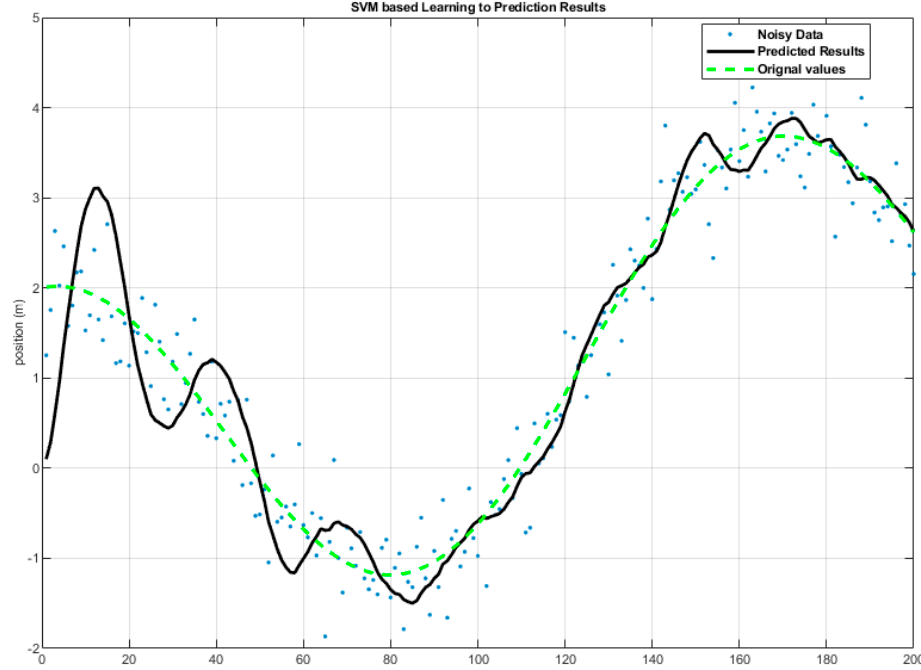
Figure 10. SVM-based alpha-beta filter output.